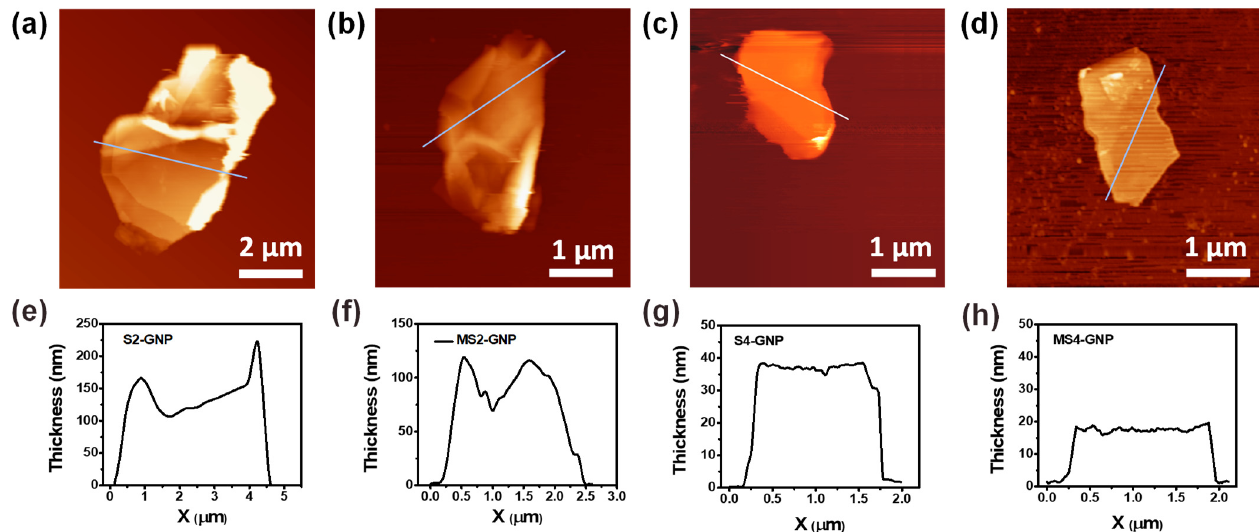
Figure 2. Atomic force microscopy (AFM) images and line profiles along the white lines of ( a,e ) S2-, ( b,f ) MS2-, ( c,g ) S4- and ( d,h ) MS4-GNPs, which had average thicknesses of 140, 98, 35, and 17 nm, respectively.